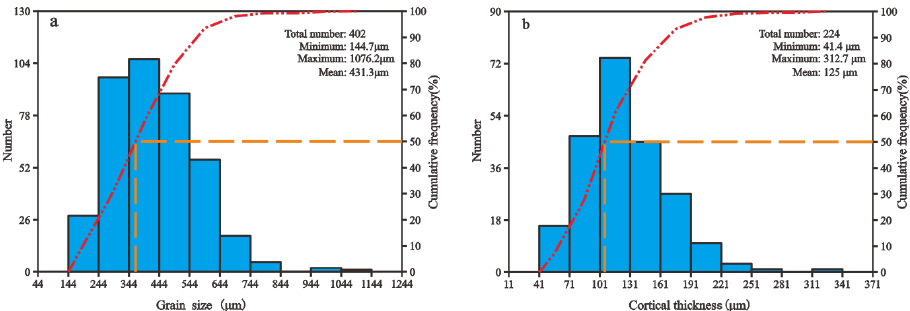
Figure 5. Scanning electron micrographs of the sample. ( a , b ) ASB images show concentric micritic dolomitic layer, micritic dolomitic and quartz nucleus, and pyrite in nucleus and cortices; ( c ) SE image shows that planar-e (euhedral) dolomite crystals were developed on the surface of ooids and in the pores; ( d ) SE image shows inner micritic dolomite with a plate pattern and outer euhedral dolomite crystal with a rhombic shape; ( e ) SE image shows minor kaolinite in the nucleus; ( f ) SE image shows that pyrites developed in the micritic dolomitic cortices.